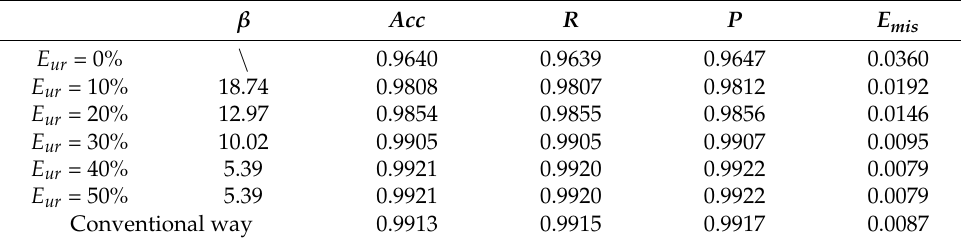
Table 3. Performance of decision-making on two-dimensional data.